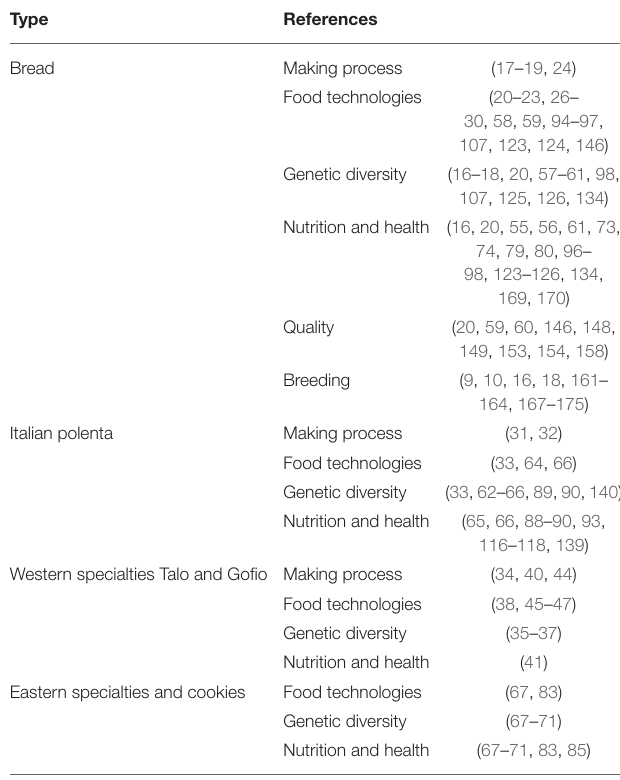
TABLE 1 | Research lines about traditional maize food in Europe and references for each